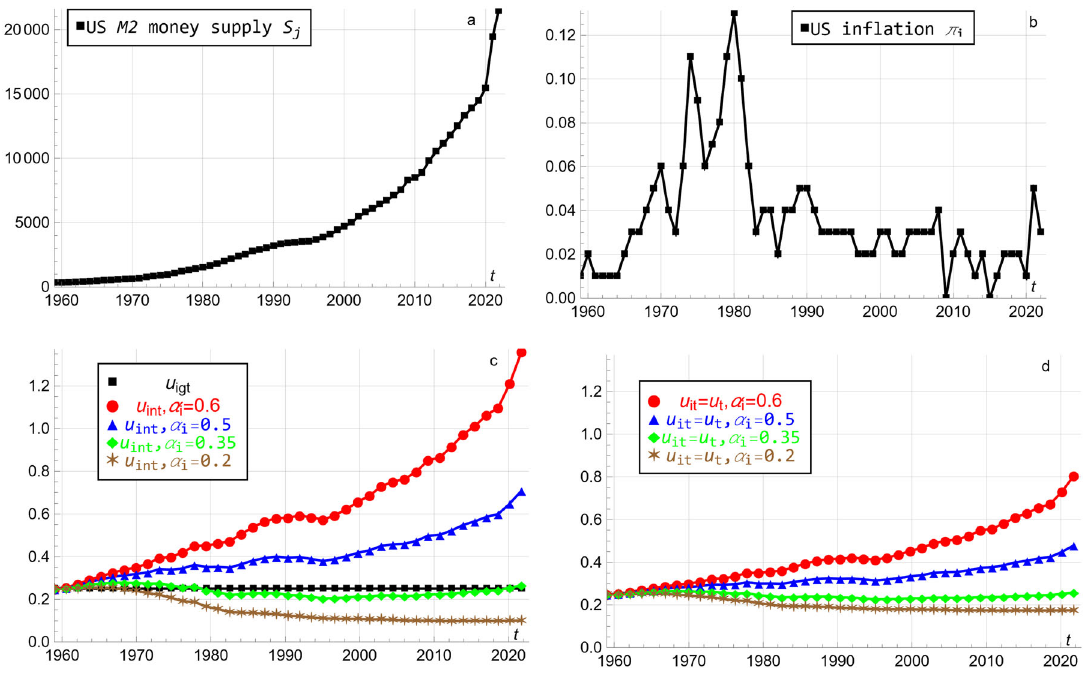
Fig. 2 US M2 money supply, US in fl ation, player utilities and society ’ s utility. a US M2 money supply S j 1959 – 2021 in $billion. b US in fl ation π i 1959 – 2021. c and d Player i ’ s utilities u igt , u int , u it , u t as functions of time t when s it ¼ p it ¼ q it ¼ 0 : 5, μ